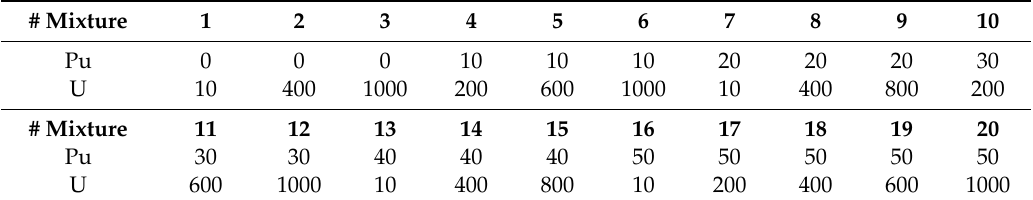
Table 1. The composition of 20 Pu-U mixtures (mg / L) in 1.5 M HNO 3